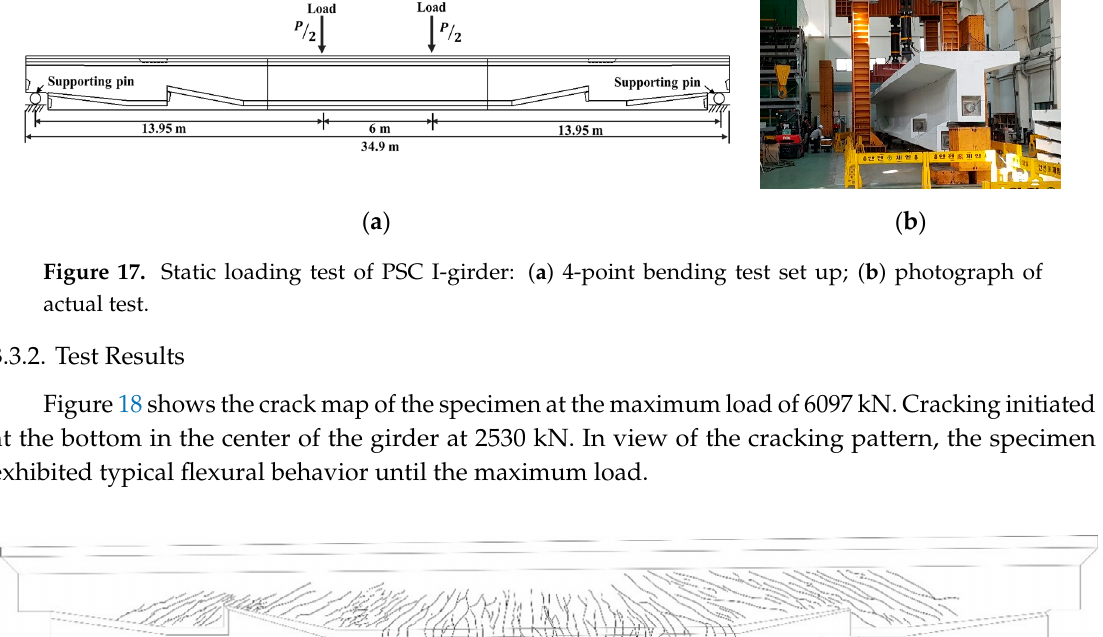
Figure 18. Crack map of specimen at maximum load.